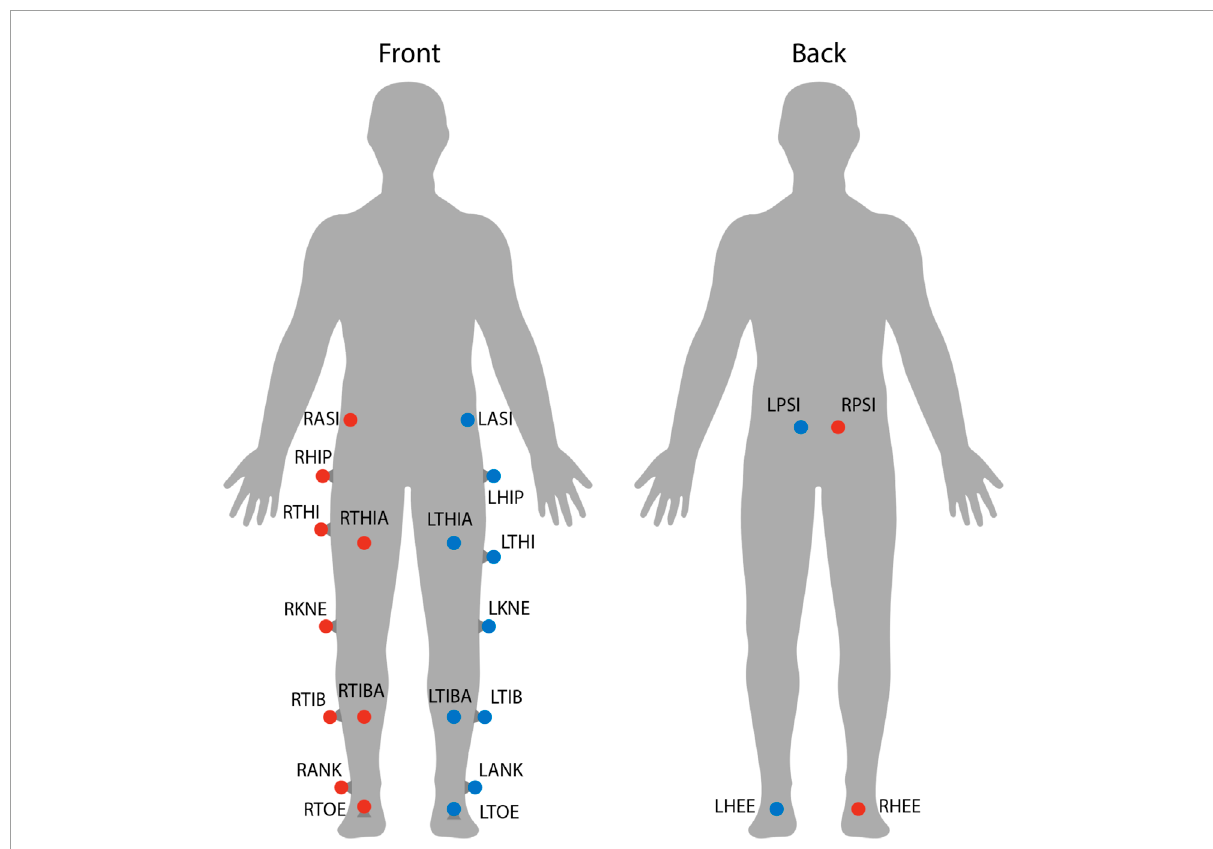
FIGURE 3 Marker locations on each subject. Twenty-two reflective markers were used for motion capture analysis. The center of mass was estimated as the average between LASI, RASI, LPSI, and RSPI markers.